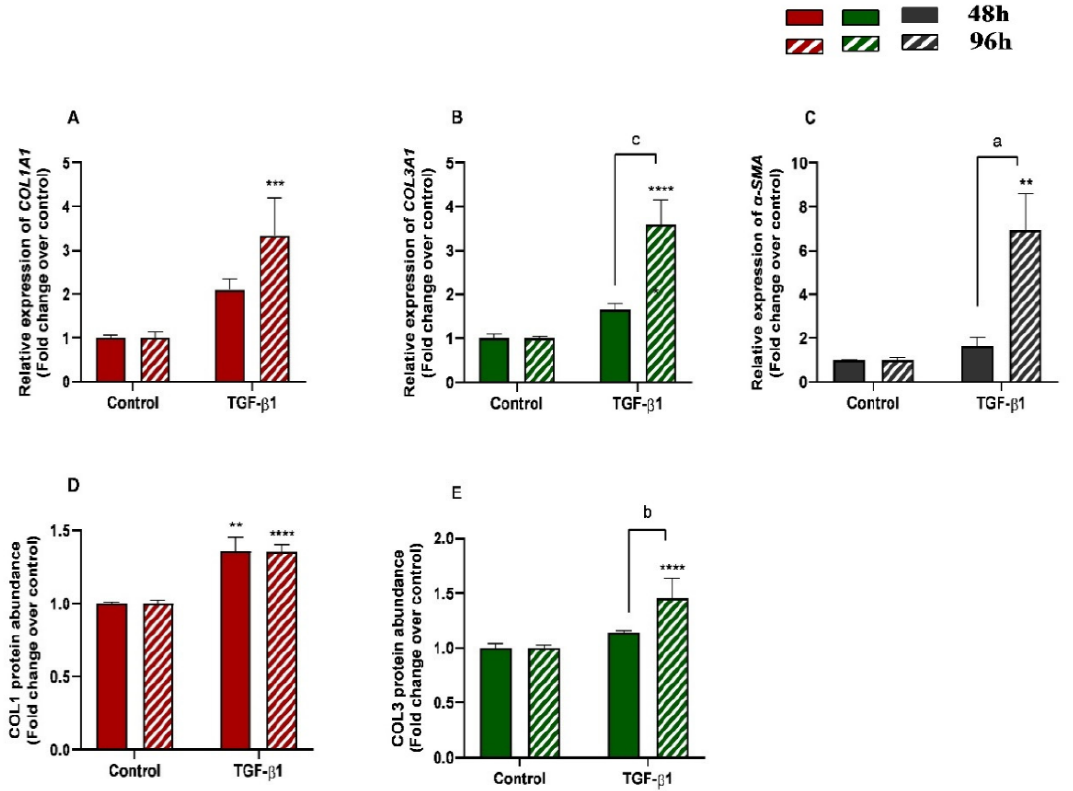
Figure 2. Relative levels of ( A ) collagen type I ( COL1A1 ), ( B ) collagen type III ( COL3A1 ), and ( C ) α‐ smooth muscle actin ( α‐ SMA ) mRNA, and of ( D ) COL1 and ( E ) COL3 protein concentrations in mare endometrial fibroblasts after incubation with TGF ‐β 1 (10 ng/mL) for 48 h and 96 h; n = 5 . All values are expressed as percentage of change from respective hour control (non ‐ treated fibroblasts). Bars represent mean ± SEM. Asterisks indicate significant differences between treatment and the respective control (** p < 0.01, *** p < 0.001, **** p < 0.0001); a and b letters indicate significant differ ‐ ences between treatment hours (a— p < 0.05; b— p < 0.01; c— p < 0.001).